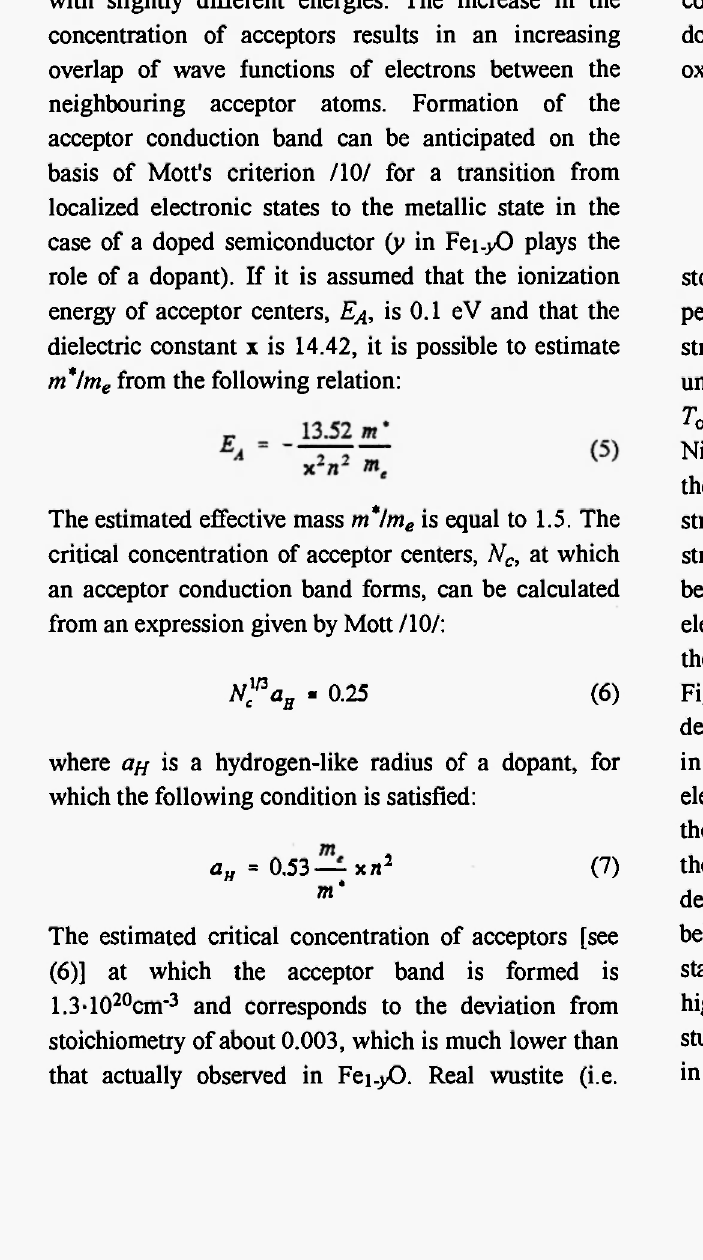
Fig. 7: Model of electronic structure of